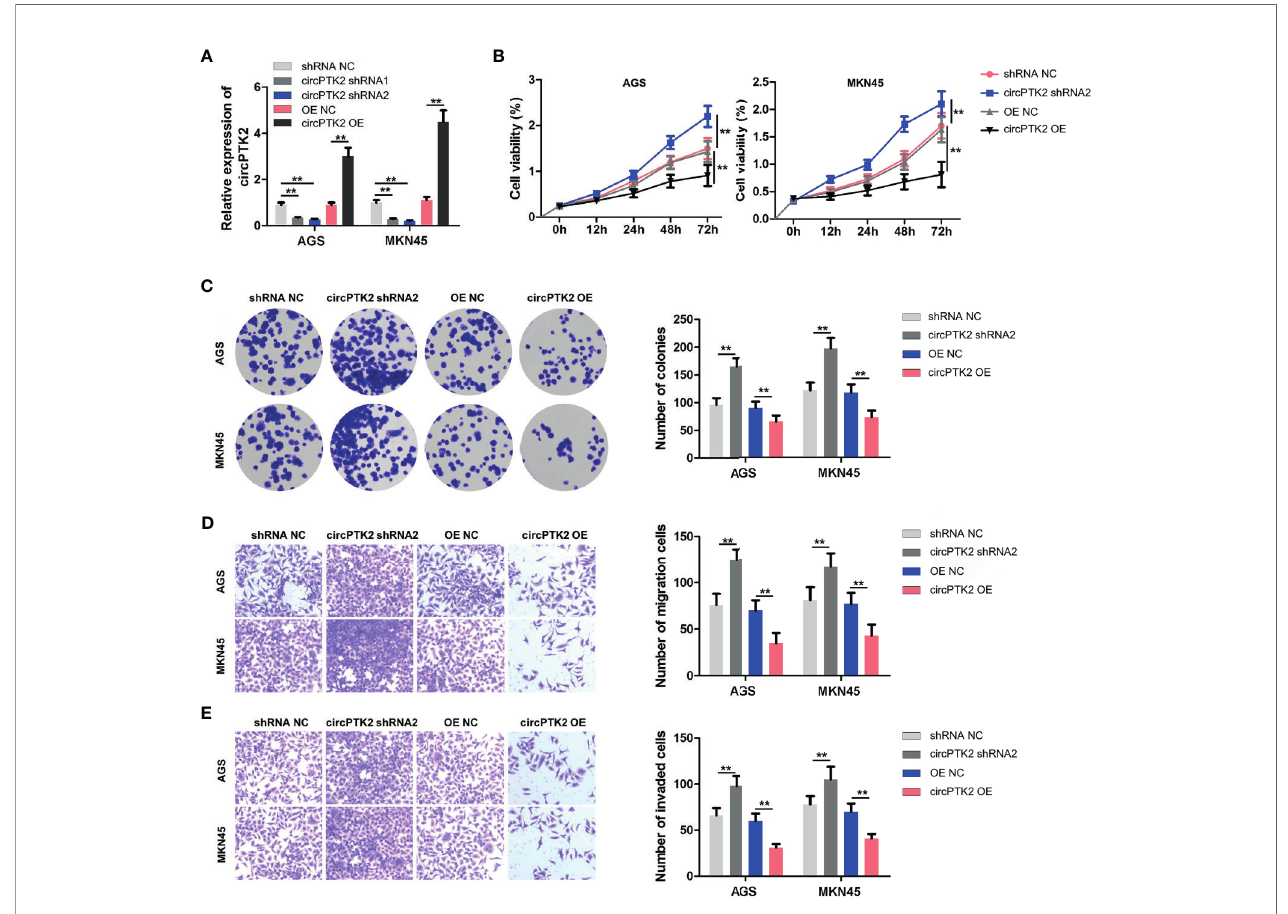
FIGURE 3 | Overexpression of circPTK2 inhibits gastric cancer cell proliferation, migration, and invasion. (A) RT-qPCR analysis of circPTK2 level in AGS and MKN45 cells treated with circPTK2 shRNA1, circPTK2 shRNA2, or circPTK2-OE. (B) AGS and MKN45 cells were treated with circPTK2 shRNA2 or circPTK2-OE. Cell viability was measured by CCK-8 assay. (C) Cell proliferation was determined by colony formation staining assay. (D) Cell migration and (E) cell invasion were measured by transwell assays. ** p < 0.01. The signi fi cance between the four groups was analyzed by one-way